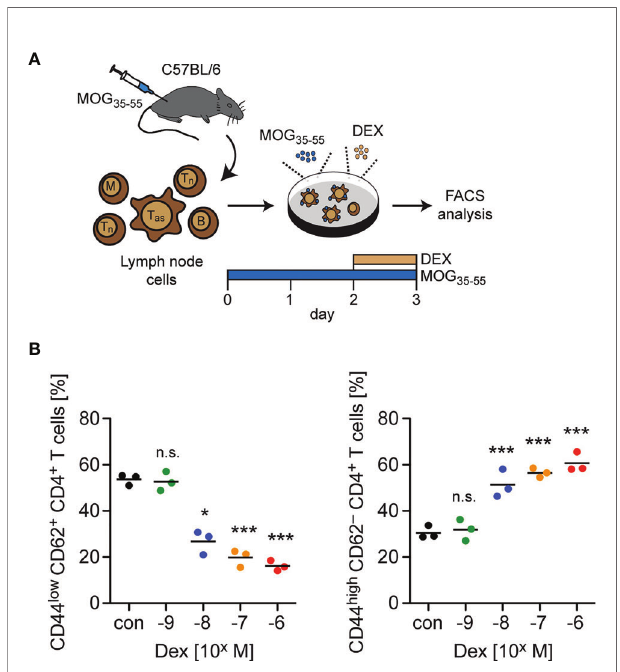
FIGURE 4 | Enrichment of T cells with an activation/memory phenotype after GC treatment in vitro . (A) Setup of the experimental model. (B) Percentages of live/dead – (naïve) CD44 low CD62L + CD4 + T cells (left panel) and live/dead – (activated) CD44 high CD62L – CD4 + T cells (right panel) after 3 days of cell culture in the absence (con) or presence of the indicated concentrations of Dex for the last 24 hrs. Each dot corresponds to cells from one individual mouse, the horizontal line represents the mean. N=3 (biological replicates from individual mice). Statistical analysis was performed by One-way ANOVA followed by a Newman-Keuls Multiple Comparison test. Levels of signi fi cance (depicted for the comparison between control and Dex-treated cultures): n.s., not signi fi cant; *p < 0.05; ***p < 0.001. T as , antigen-speci fi c T cells; T n , naïve T cells; B, B cells; M, myeloid